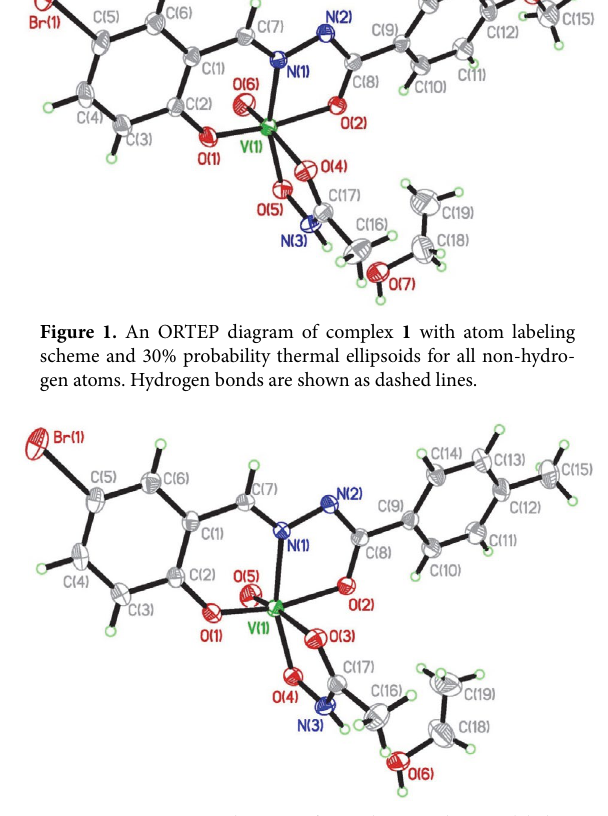
Figure 2. An ORTEP diagram of complex 2 with atom labeling scheme and 30% probability thermal ellipsoids for all non-hydrogen atoms. Hydrogen bonds are shown as dashed lines.